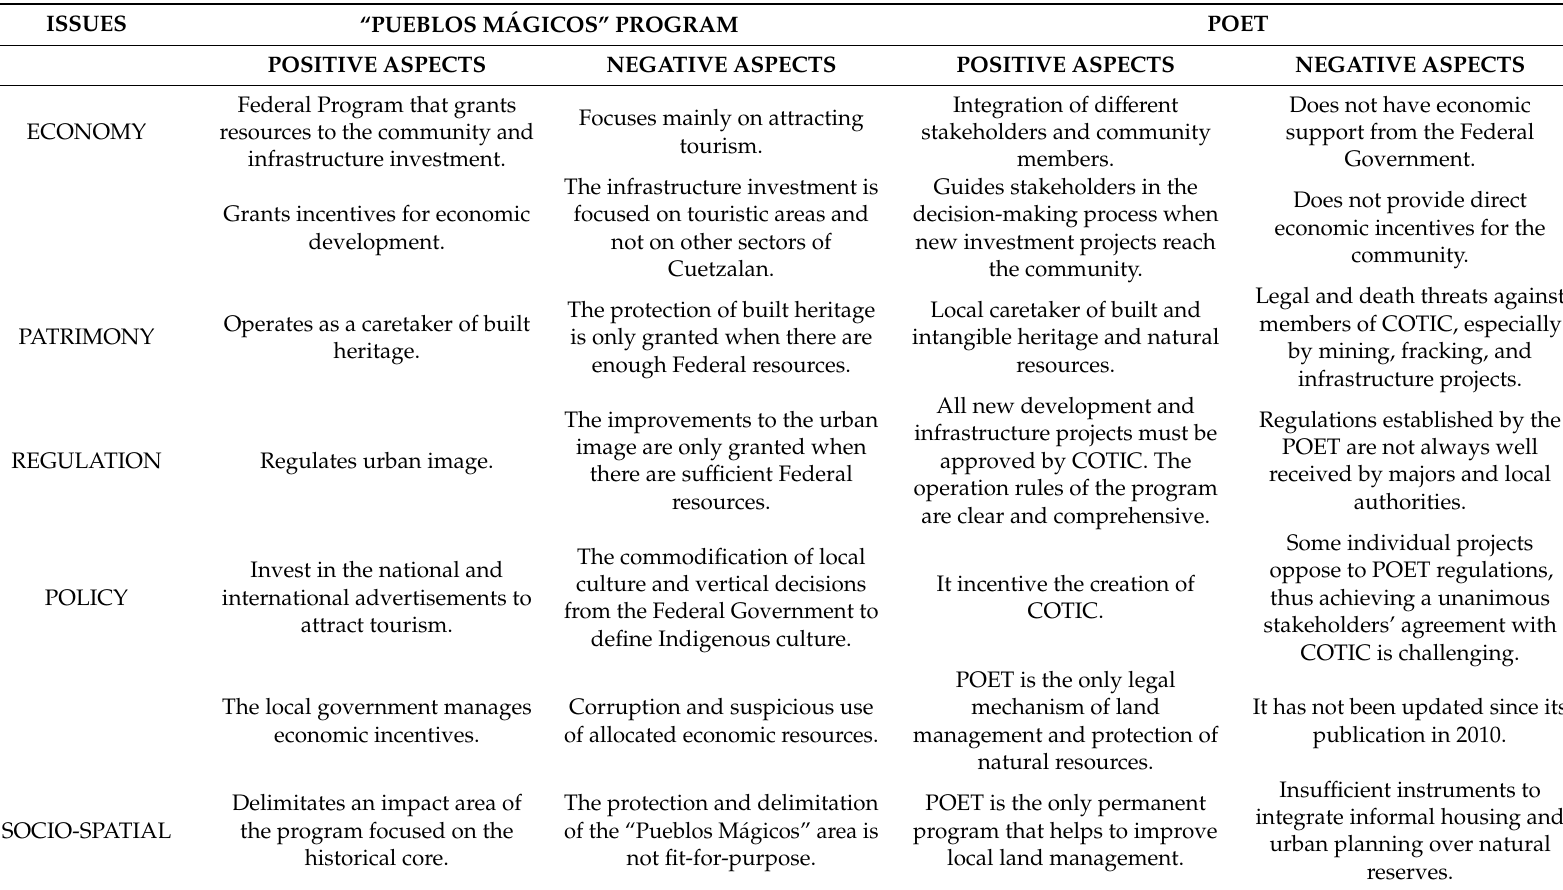
Table 5. Positive and negative aspects of the “Pueblos M á gicos” Program and POET (Programa de Ordenamiento Ecol ó gico y Territorial). Source: Schumacher